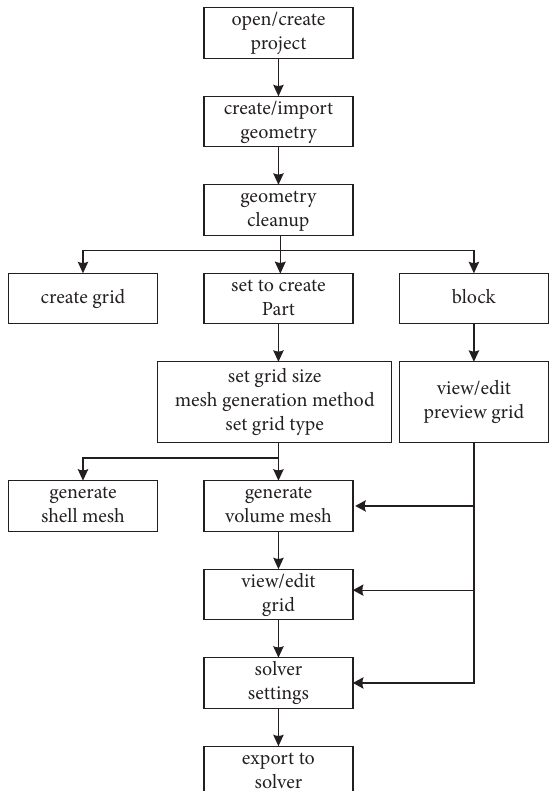
Figure 5: ANSYS ICEM CFD meshing process.